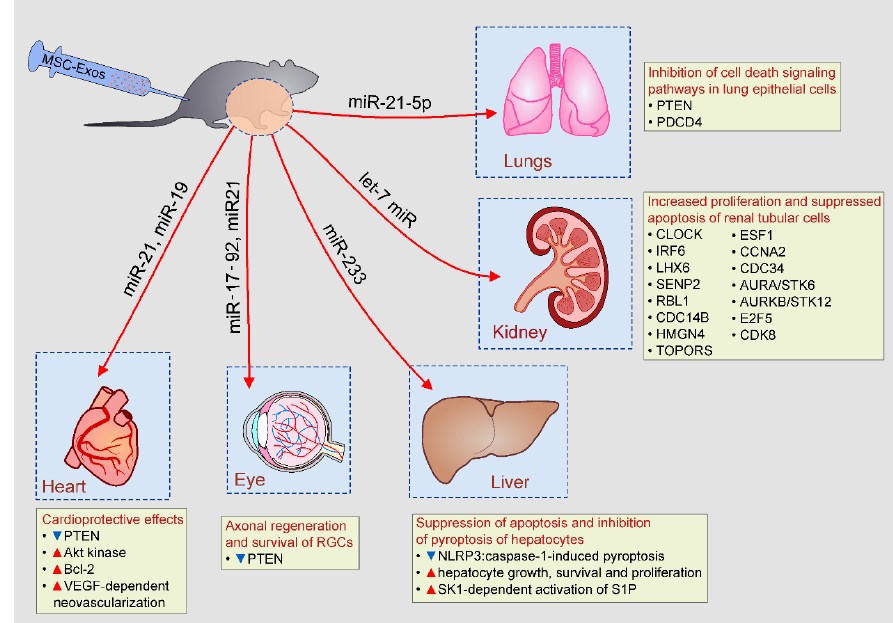
Figure 3. Beneficial effects of MSC-Exos in tissue repair and regeneration. MSC-Exos, in miR-19,